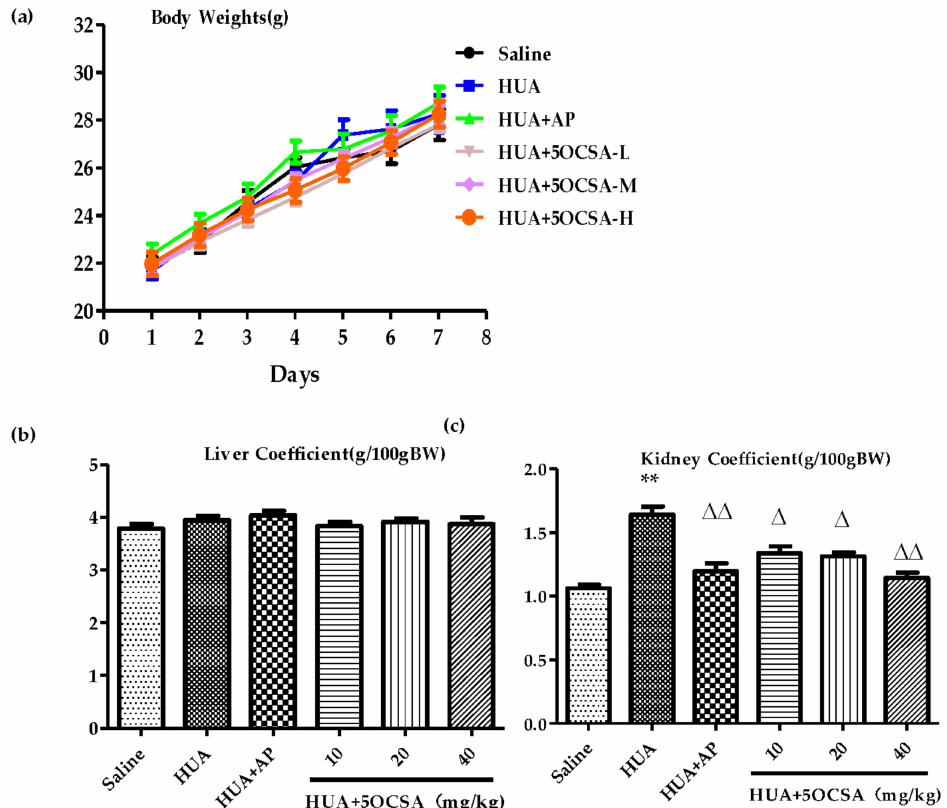
Figure 3. Effects of different doses of 5OCSA on BWs and organ coefficients in HUA mice. ( a ) Changes of BWs in different groups (n = 8 in each group). Coefficients of liver ( b ) and kidney ( c ) were calculated and plotted via GraphPad. ** p < 0.01, compared with saline group; ∆ p < 0.05; ∆∆ p < 0.01, compared with HUA group. 5OCSA-L: low dose of 5- O -caffeoylshikimic acid; 5OCSA-M: medium dose of 5OCSA; 5OCSA-H: high dose of 5OCSA; BWs: bodyweights; HUA: